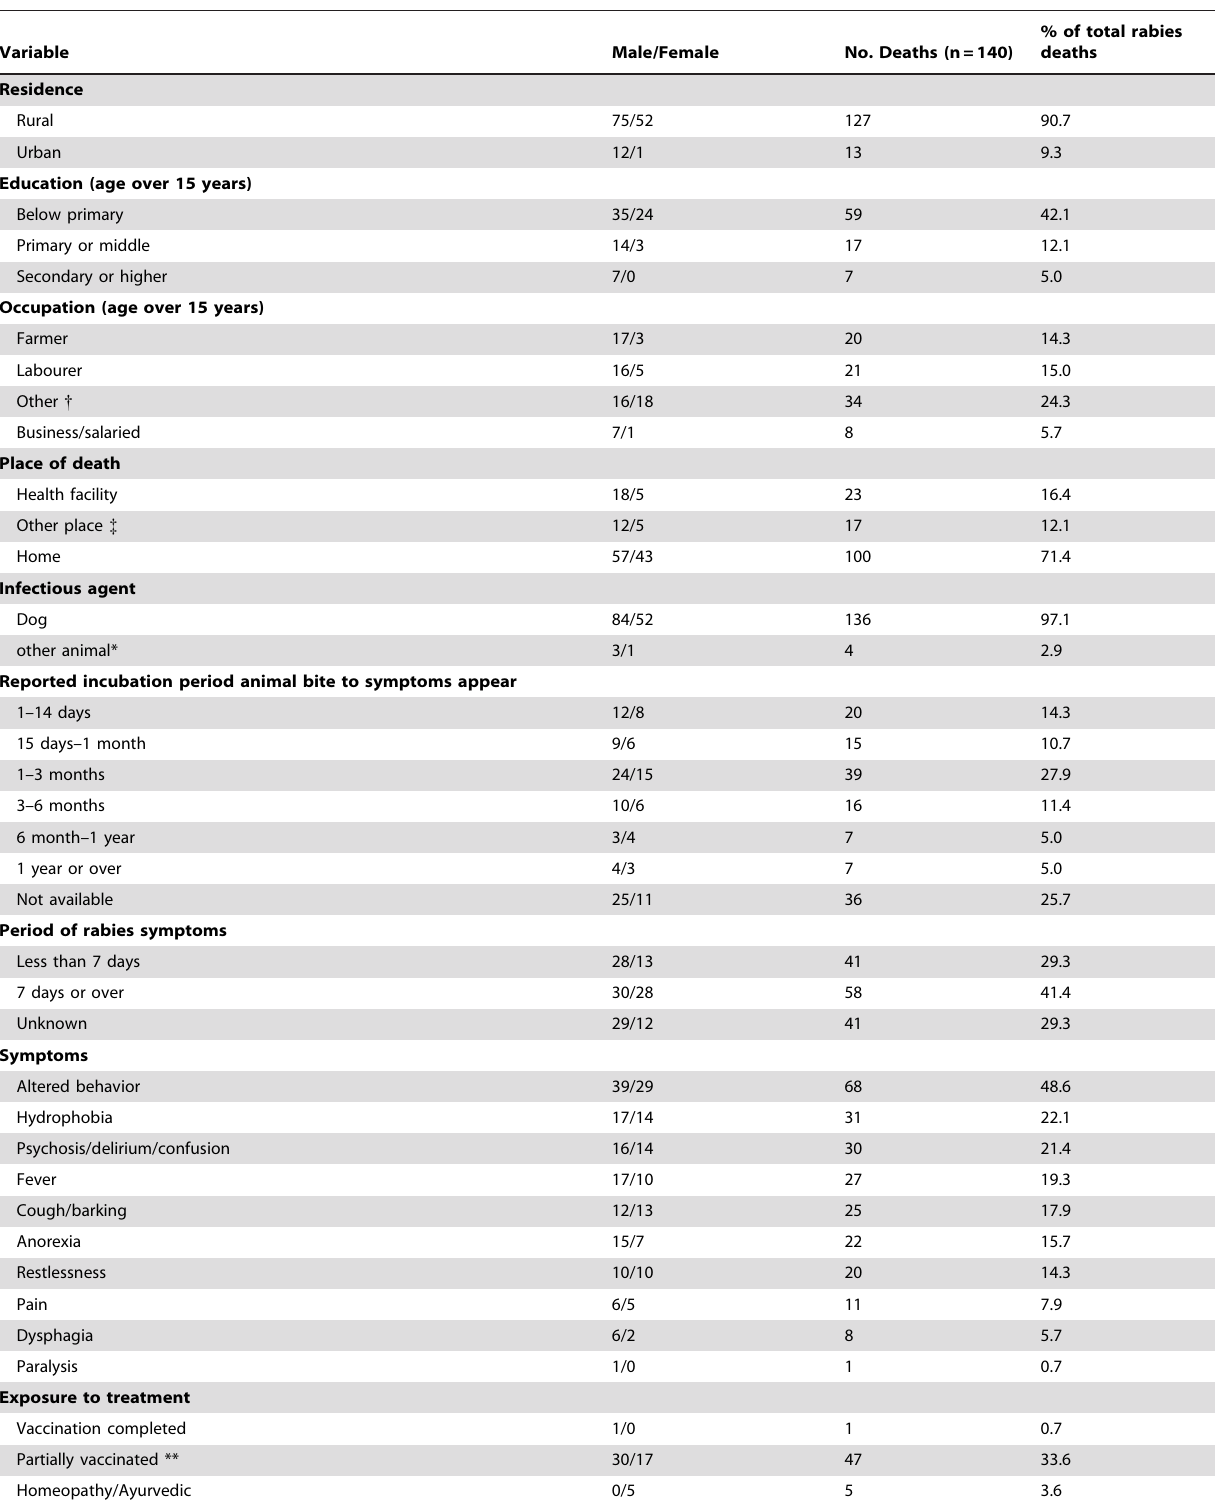
Table 1. Variables related to rabies deaths in